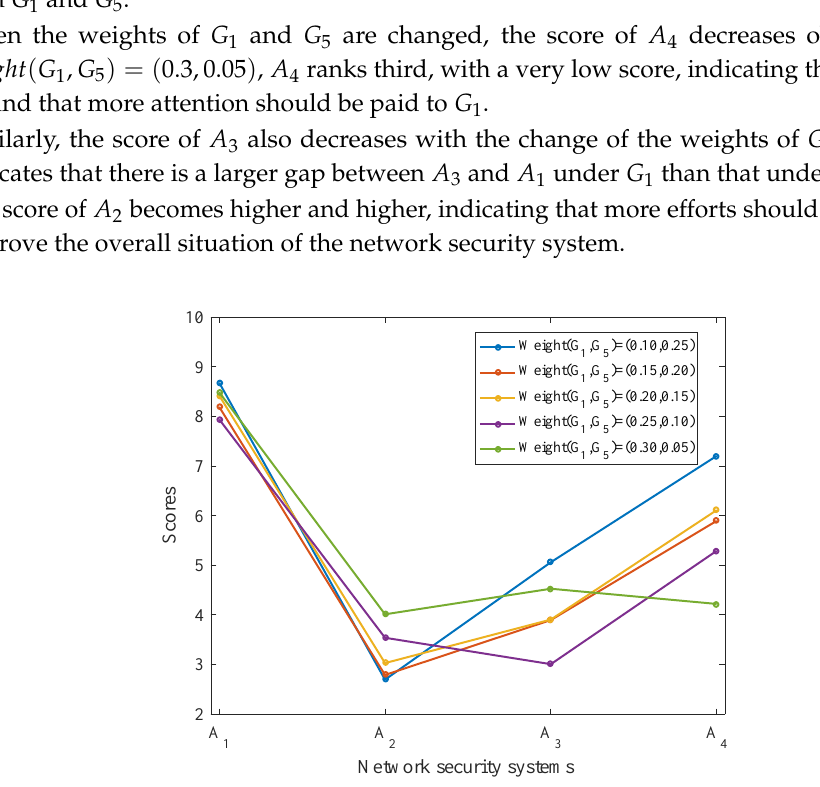
Figure 7. The ranking of the network security